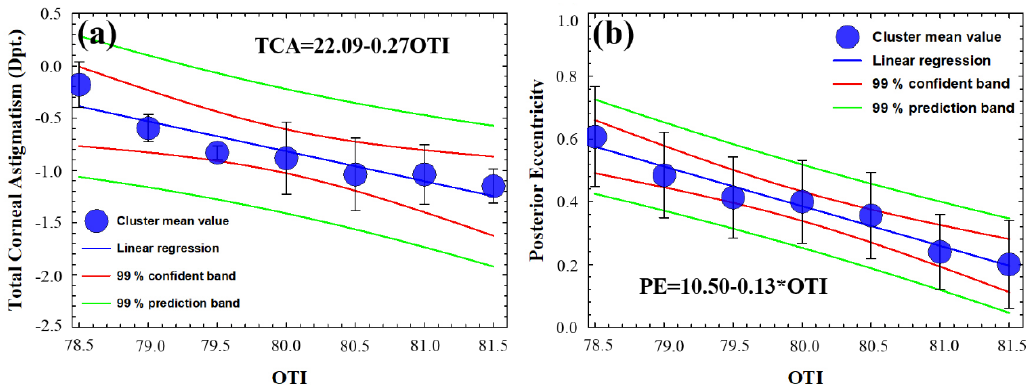
Figure 5. Mean clustered OTI values as function of total corneal astigmatism (TCA) ( a ) and posterior eccentricity (PE) ( b ) for all subjects. Standard deviation of the clustered data, equations, confident, and prediction bands of the regression analysis are included.